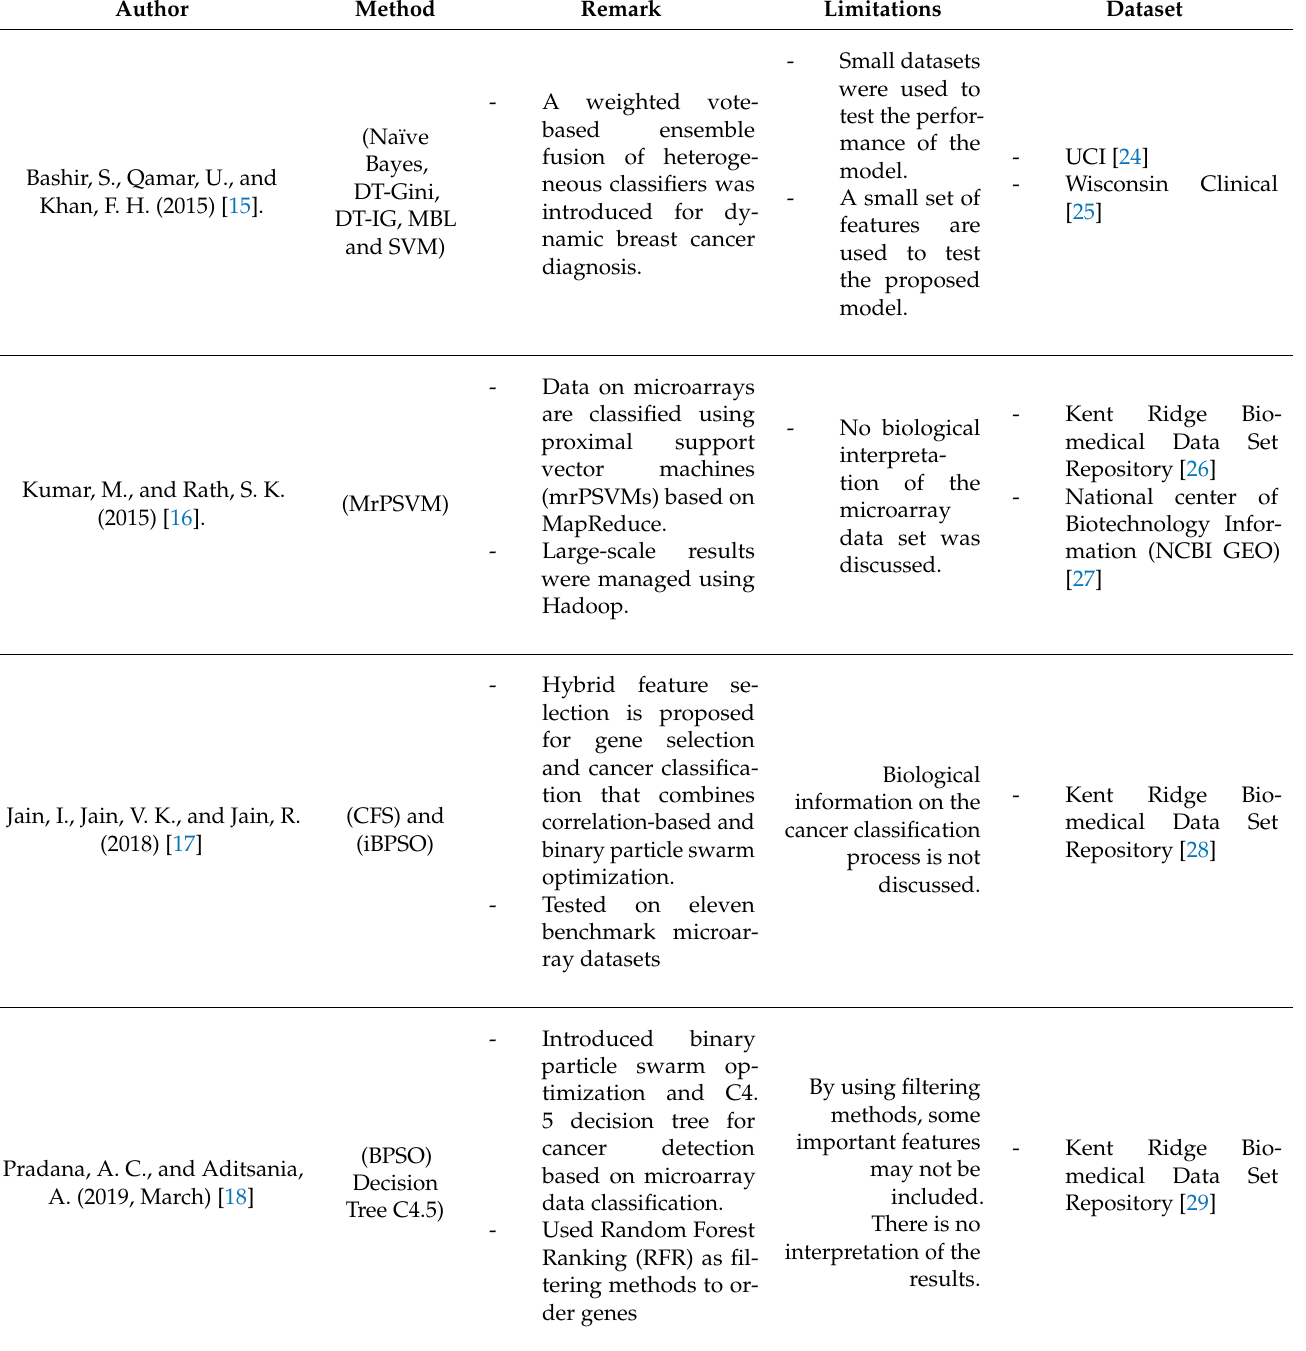
Table 1. Review of previous studies on the cancer microarray data